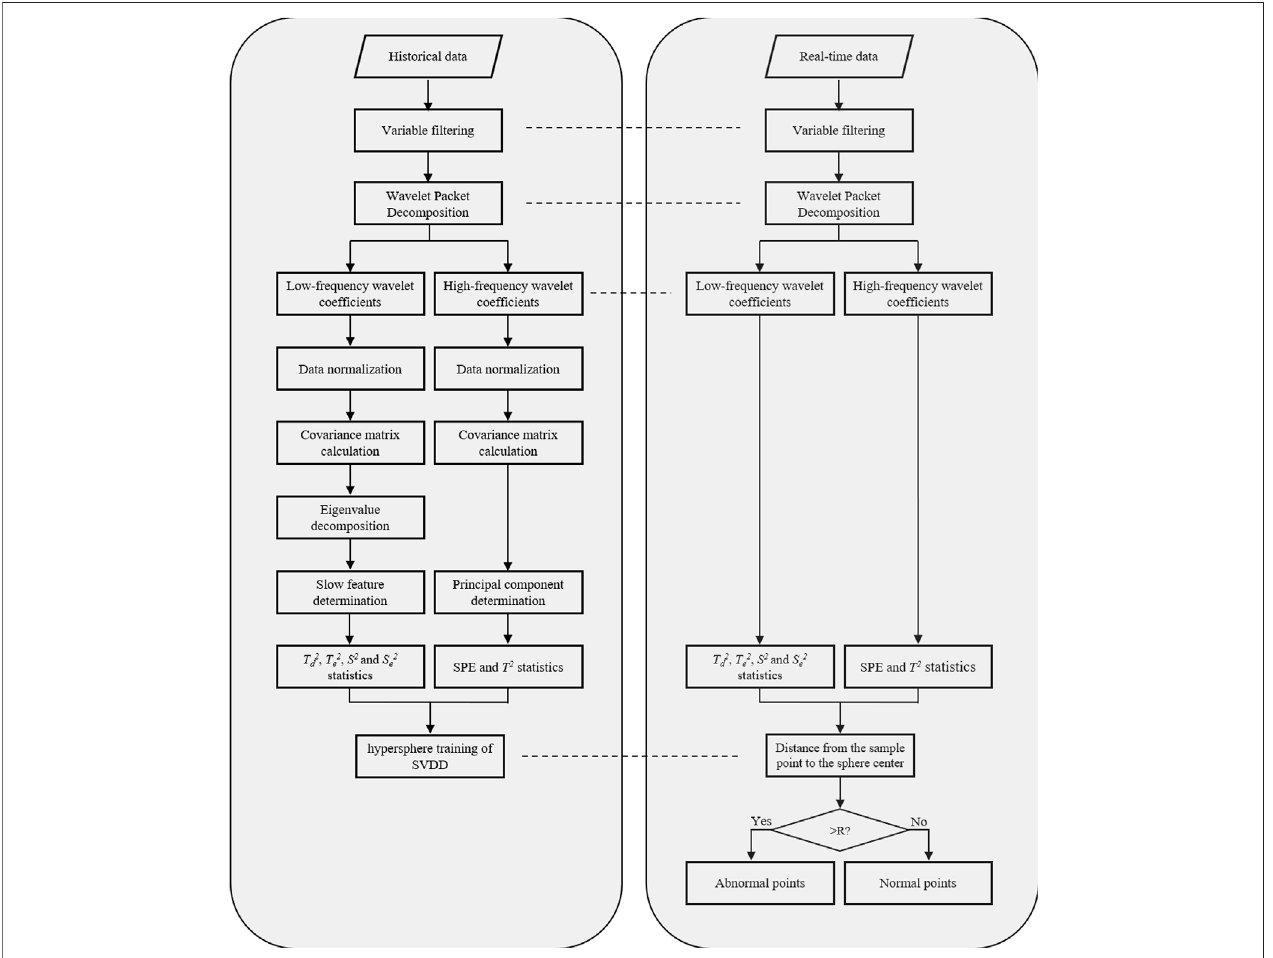
FIGURE 2 | The fl ow chart of the proposed multi-scale process monitoring